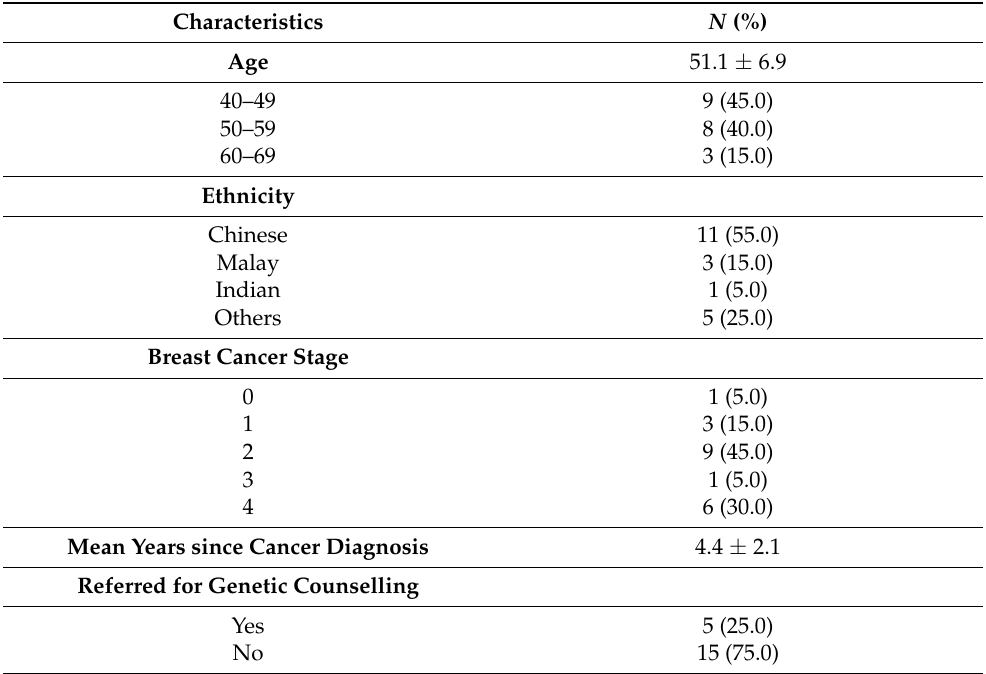
Table 1. Demographic characteristics of participants ( n =